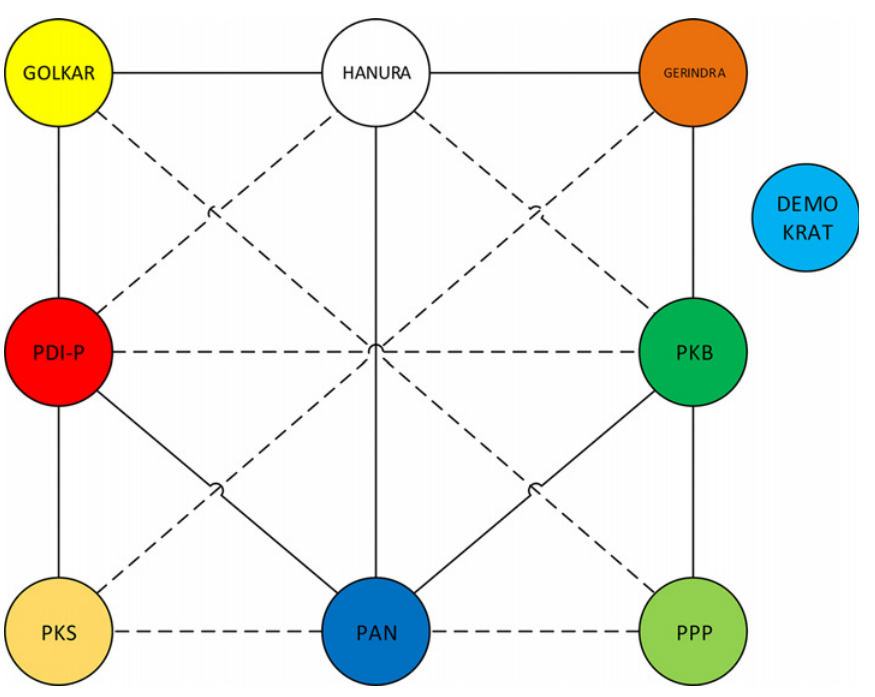
Fig 11. Conflict Graph.